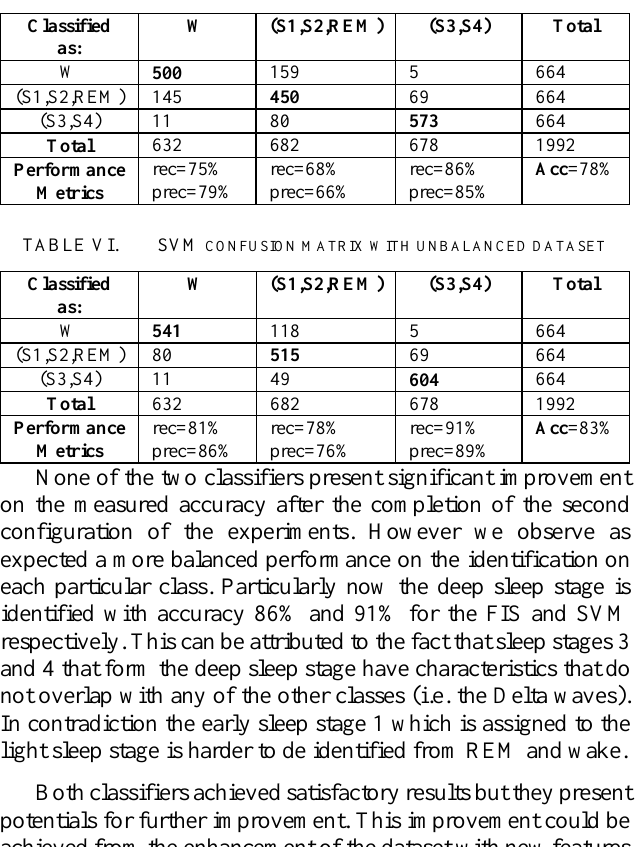
FIS CONFUSION MATRIX WITH BALANCED DATASET